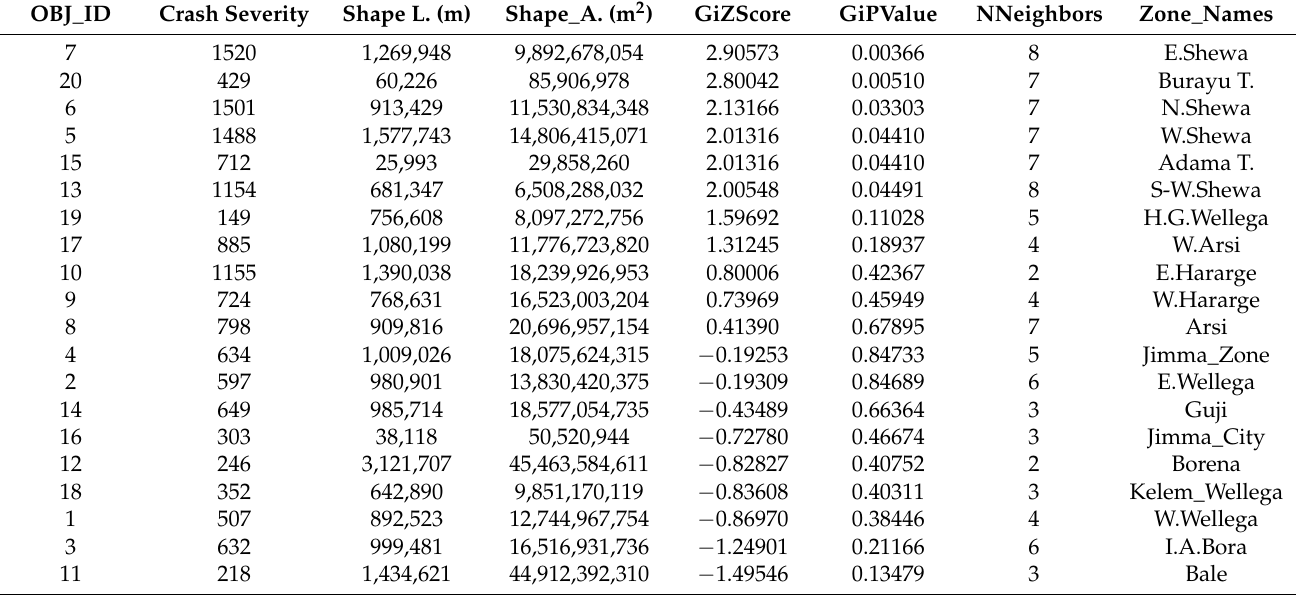
Table 3. The Attribute of Crash Hot Spot Result of Getis Ord Gi*